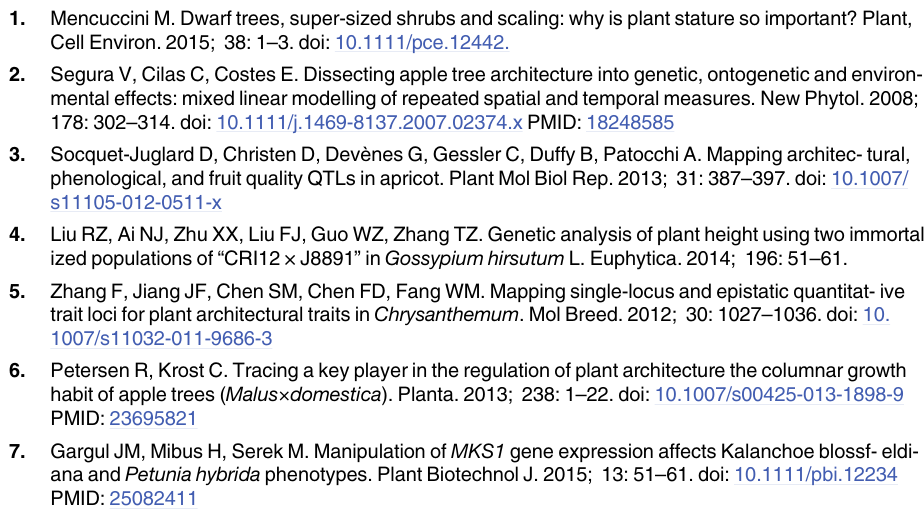
S1 Fig. The distribution diagram of SLAF tags on the genome of Eucalyptus grandis . (TIF) S1 Table. The DNA sequences and length of the specific markers related to dwarf traits in crape